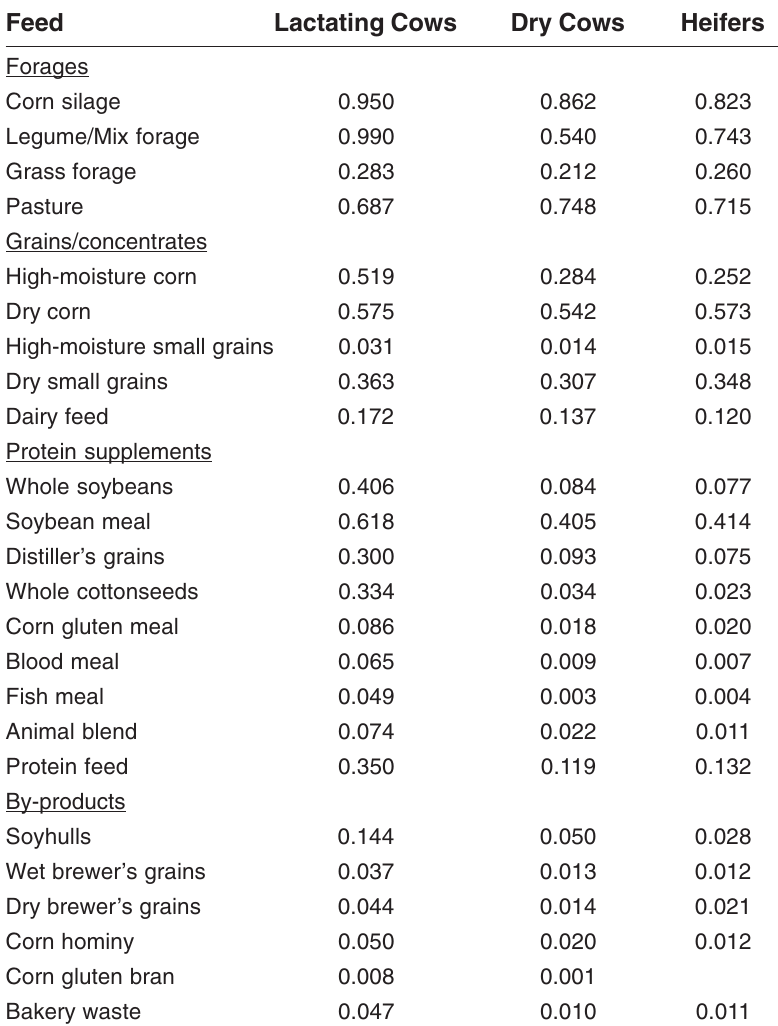
Fraction of Farms Reporting Feeds Fed to Selected Animal Groups on Holstein Dairy Herds (n =